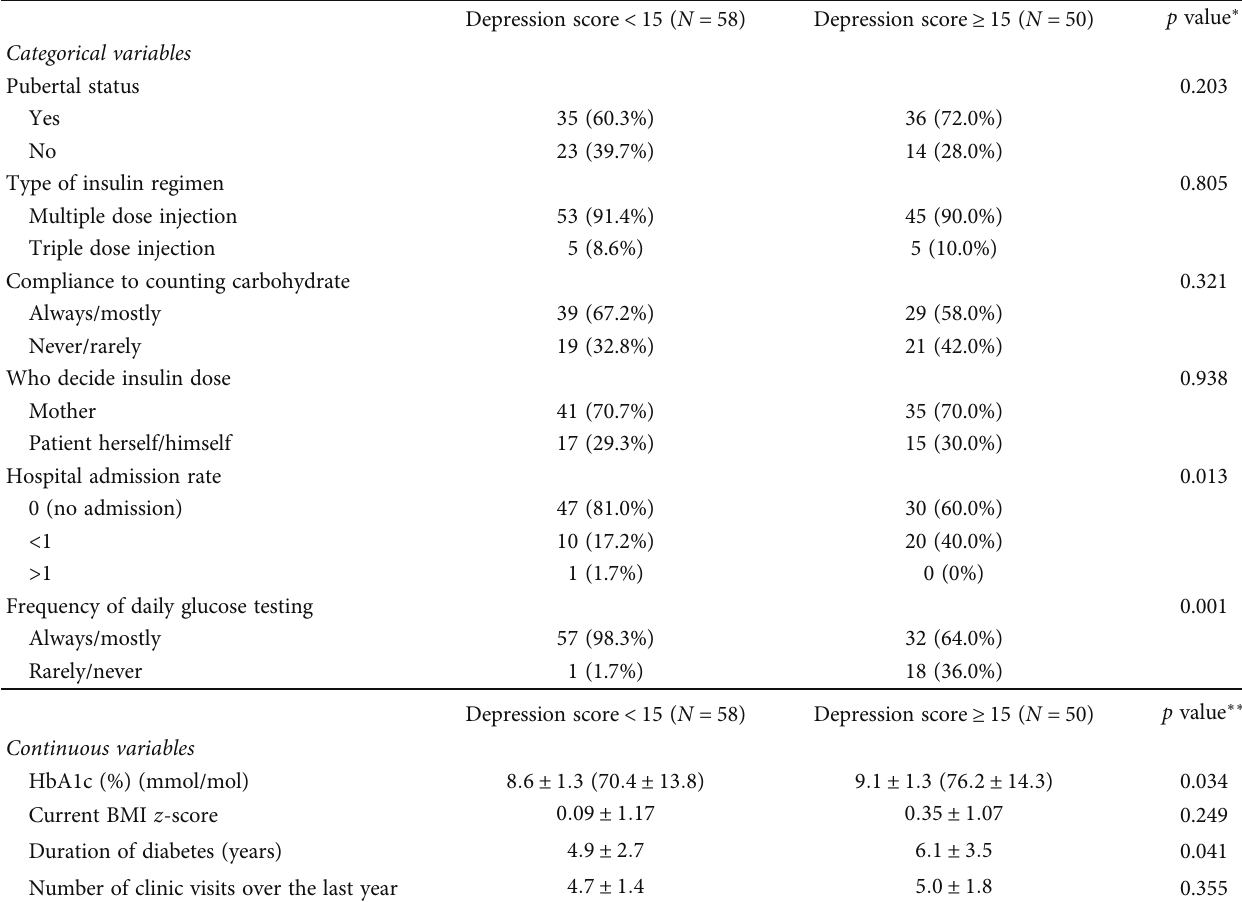
Table 2: Di ff erences in the clinical and diabetes care practice characteristics between the 2 groups of patients in the